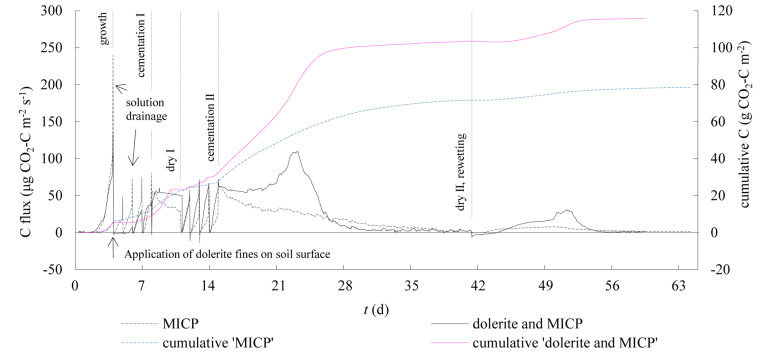
Time series of soil-atmosphere CO2 fluxes of sandy soil columns treated with the traditional MICP treatment (MICP) and using dolerite fines applied on the soil surface as source for calcium (dolerite and MICP). CO2 fluxes and cumulative CO2 emission link to left and right vertical axes, relatively. Divisions on bottom horizontal axis represent 1 d. The application of dolerite is indicated with a vertical arrow and ‘solution drainage’ are pointed as examples. The end of the experiment phases are indicated with dropping vertical dashed lines.